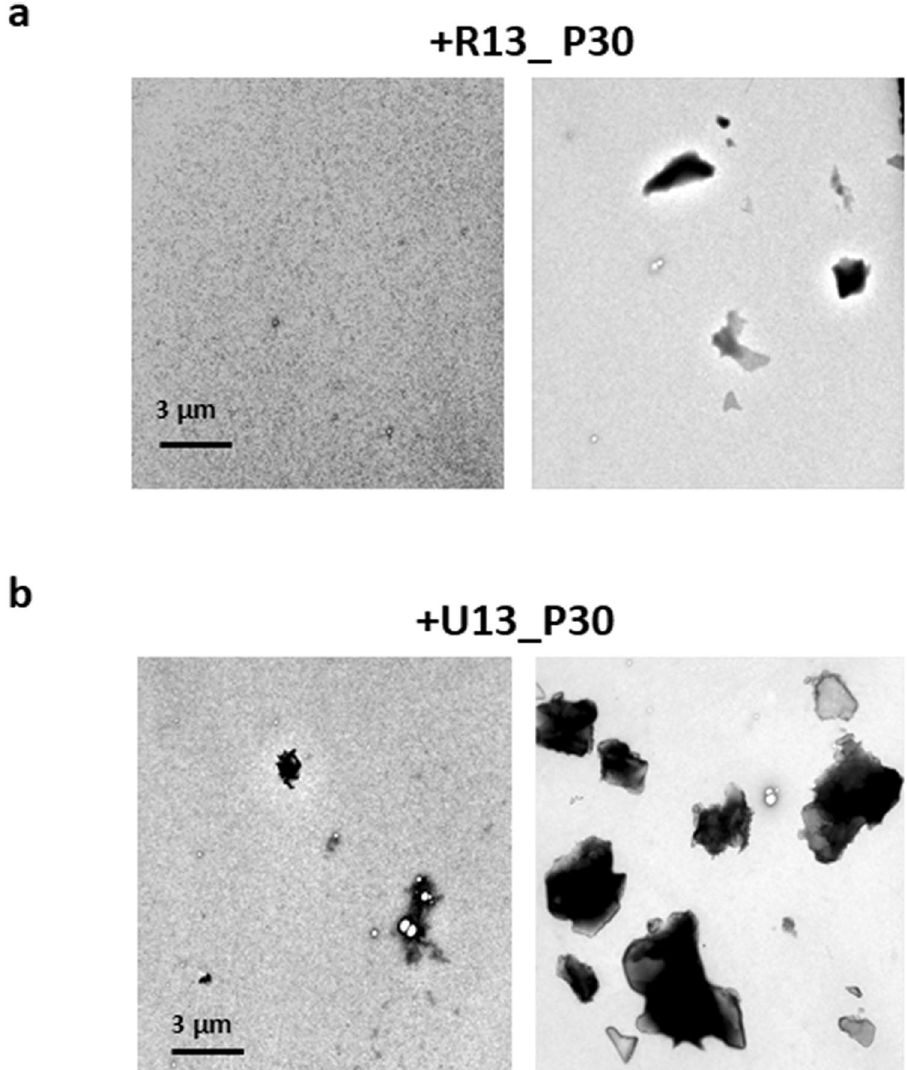
Figure 6. R13 represses the aggregation of FUS caused by pipetting while U 13 cannot, as revealed by TEM. ( a ) Representative TEM images of FUS fusion protein (MBP-BFP-FUS-GFP-6xHis) after the addition of an equimolar amount of R13 and subsequent application of 30 strokes of pipetting. ( b ) Representative TEM images of FUS protein after the addition of an equimolar amount of U 13 and subsequent application of 30 strokes of